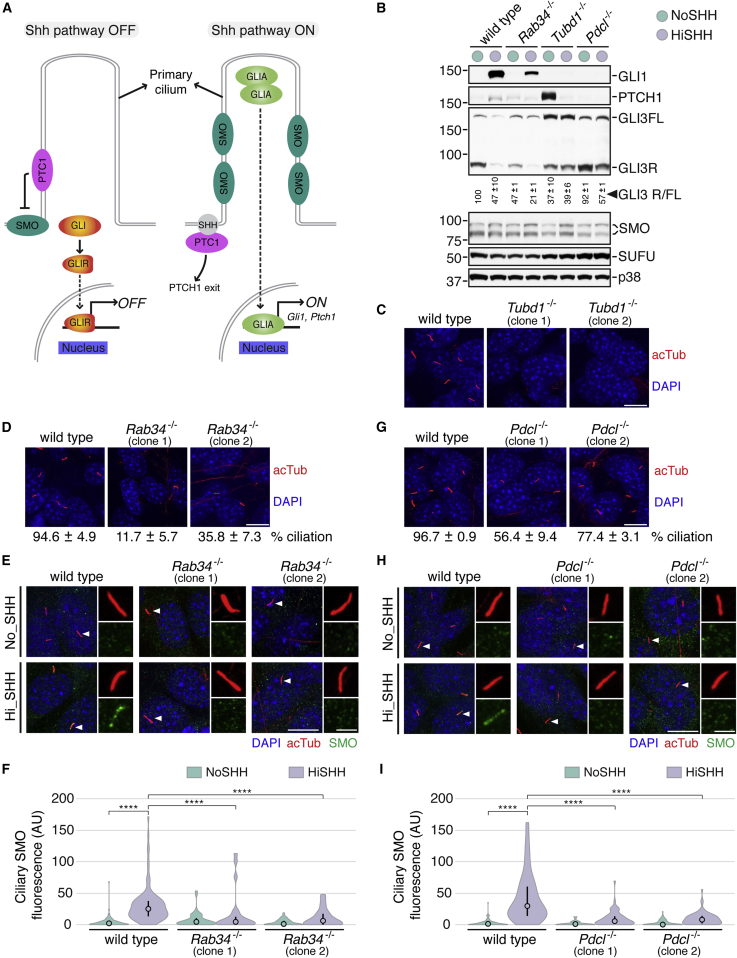
Ciliary Integrity Is Impaired in NIH/3T3 Cells Lacking TUBD1, RAB34, and PDCL(A) Ciliary localization of Hh pathway components in the presence and absence of SHH.(B) Immunoblots showing the abundance of Hh pathway proteins and a loading control (p38) in extracts of Rab34−/−, Tubd1−/−, or Pdcl−/− NIH/3T3 cells. Data from an independent set of cell lines are shown in Figure S3E.(C, D, and G) Acetylated tubulin (acTub, red) immunostaining was used to visualize primary cilia and determine the frequency of ciliated cells in wild-type NIH/3T3 cells and two independent Tubd1−/− (C), Rab34−/− (D), or Pdcl−/− (G) clonal cell lines. DAPI (blue) marks nuclei.(E and H) HiSHH-induced ciliary SMO (green) in Rab34−/− (E) and Pdcl−/− (H) cells. Arrowheads identify magnified cilia shown to the right of each panel.(F and I) The distribution of SMO fluorescence intensity (n ∼100 cilia/condition) is shown on a violin plot (see STAR Methods).Statistical significance was determined by the Kruskal-Wallis test; ∗∗∗∗p < 0.0001. Scale bars, 10 μm in merged panels and 2 μm in zoomed displays. See also Figure S3.